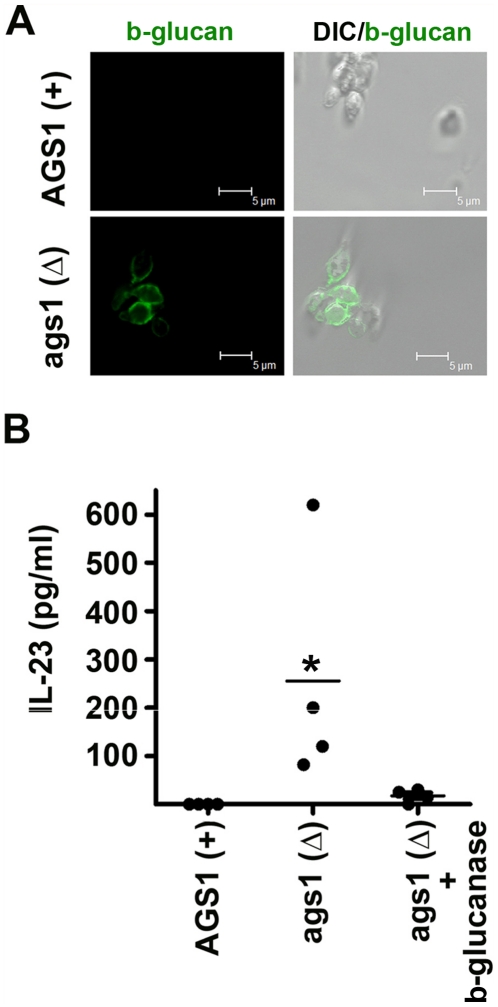
Enforced b-glucan surface exposure in the non-pathogenic Histoplasma Δags1 mutant drives IL-23 producing DCs.(A) Representative confocal microscopy images of b-glucan surface staining in yeast cells in the Δags1 mutant of Histoplasma and the isogenic complementary strain Ags1 + (left panel). Overlay images indicate the pattern of surface exposure on yeast cell surface (DIC/b-glucan immunostaining; right panel). (B) IL-23 production by DCs stimulated with the isogenic complementary strain Ags1+ of Histoplasma and the Δags1 mutant untreated or following overnight enzymatic digestion with b-glucanase (10 U/ml). IL-23 was selectively produced following stimulation of DCs with Δags1 mutant. Data are expressed as mean ± SEM values of four independent experiments. *, P<0.001, paired Student's t test.